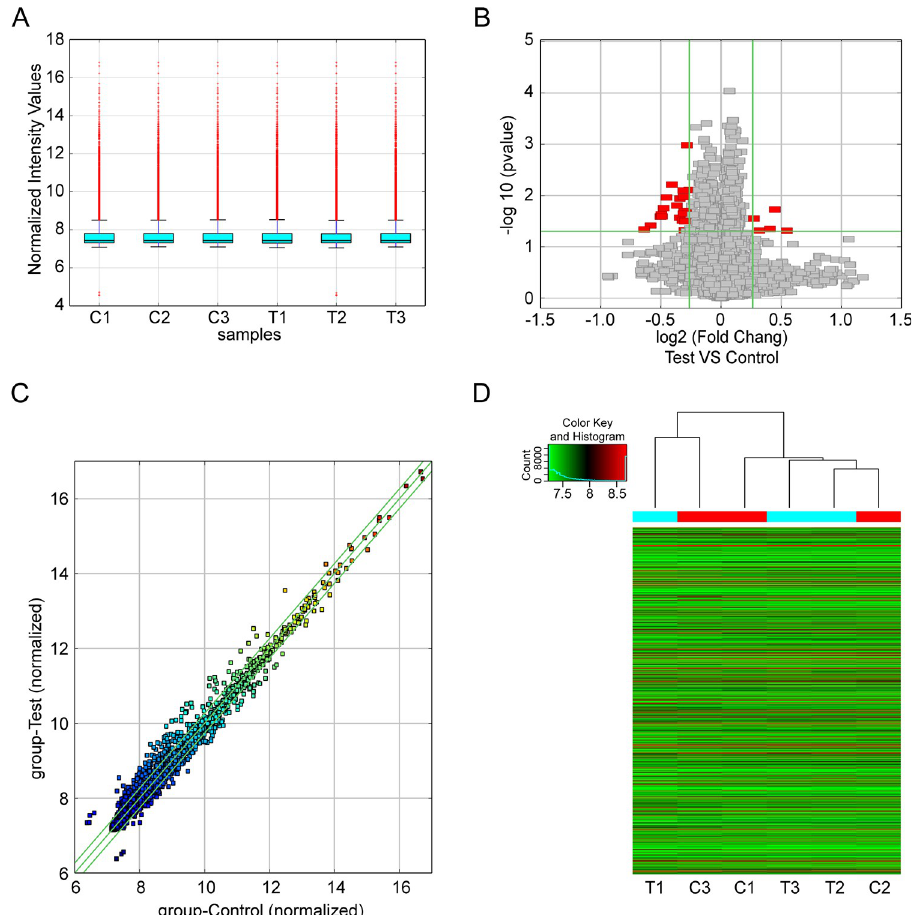
Fig 2. CircRNA expression patterns between CIH and control samples. (A) Box plot. circRNAs expression profiles were shown after normalization. (B) Volcano plot. The horizontal line indicates P = 0.05, while the red points indicate the altered circRNAs. (C) Scatter plot. Scatter plots indicate the difference of circRNAs expression. (D) Hierarchical cluster of all dysregulated circRNAs.